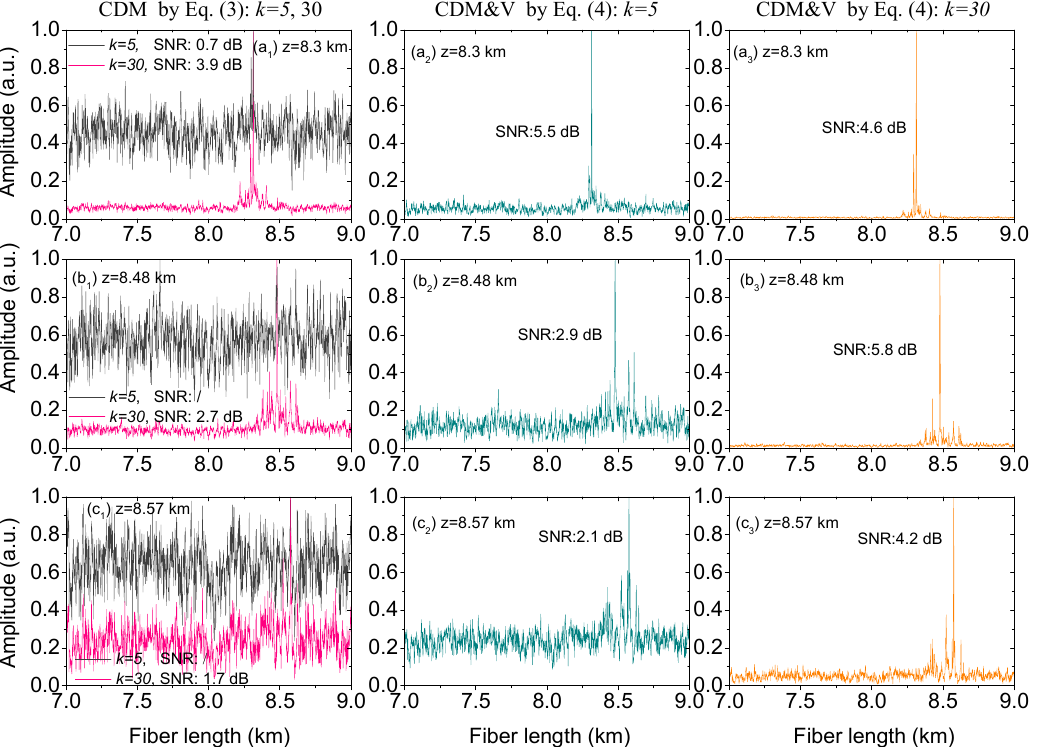
Table 2. Vibration signal comparison between the CDM and CDM&V.